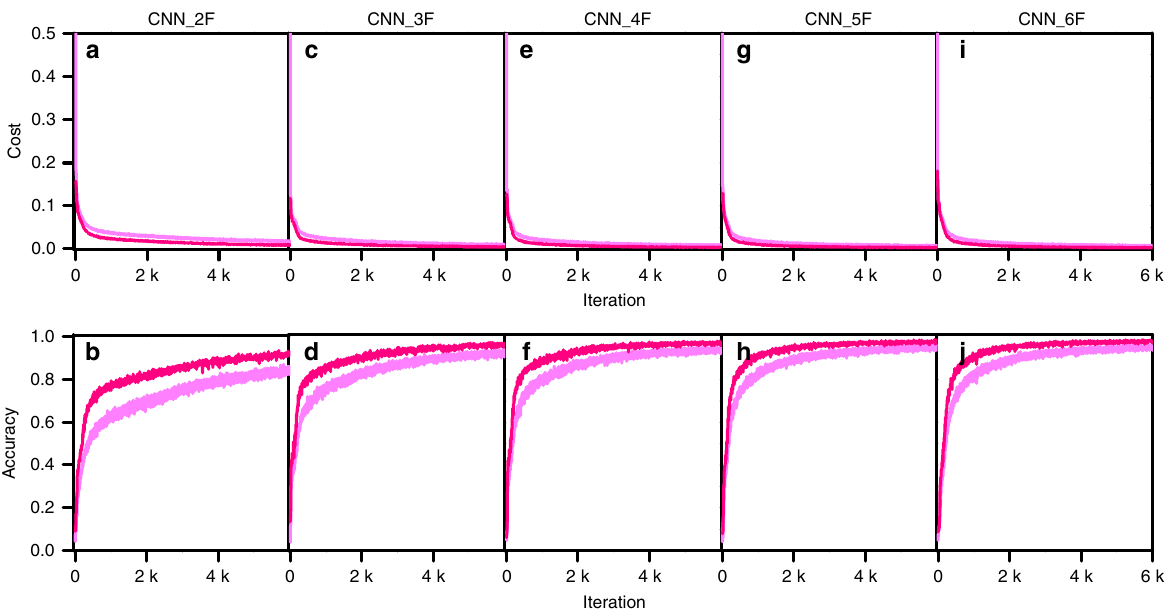
Fig. 2 The three-level-phase-fraction prediction result trained with Dataset_800k_org. The training loss/accuracy (dim pink lines) and the validation loss/accuracy (deep pink lines) plotted as a function of the iteration number up to the 10th epoch for the CNN_2F ( a , b ), CNN_3F ( c , d ), CNN_4F ( e , f ), CNN_5F ( g , h ), and CNN_6F ( i , j ) schematically represented in Supplementary Fig. 3. The training, validation, and test results for CNN_3I and CNN_6I are summarized in Supplementary Fig. 2k~n and Supplementary Table 1. It should be noted, however, that the real test data